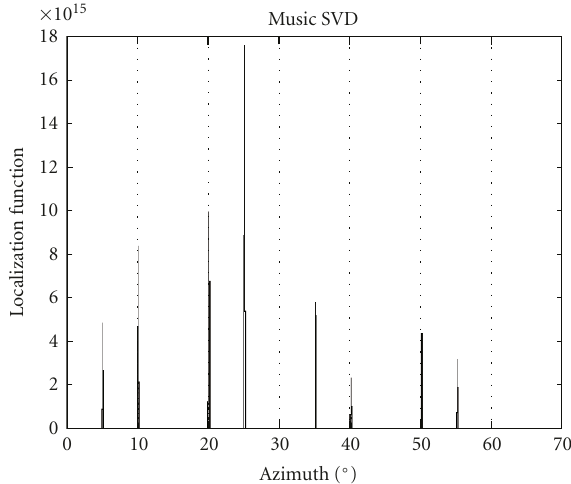
Figure 13: Standard deviation values for various SNR values obtained with noneigenvector EG method (+), MUSIC method ( ∗ ), propagator method (o), Cram´er Rao bound ( ∗